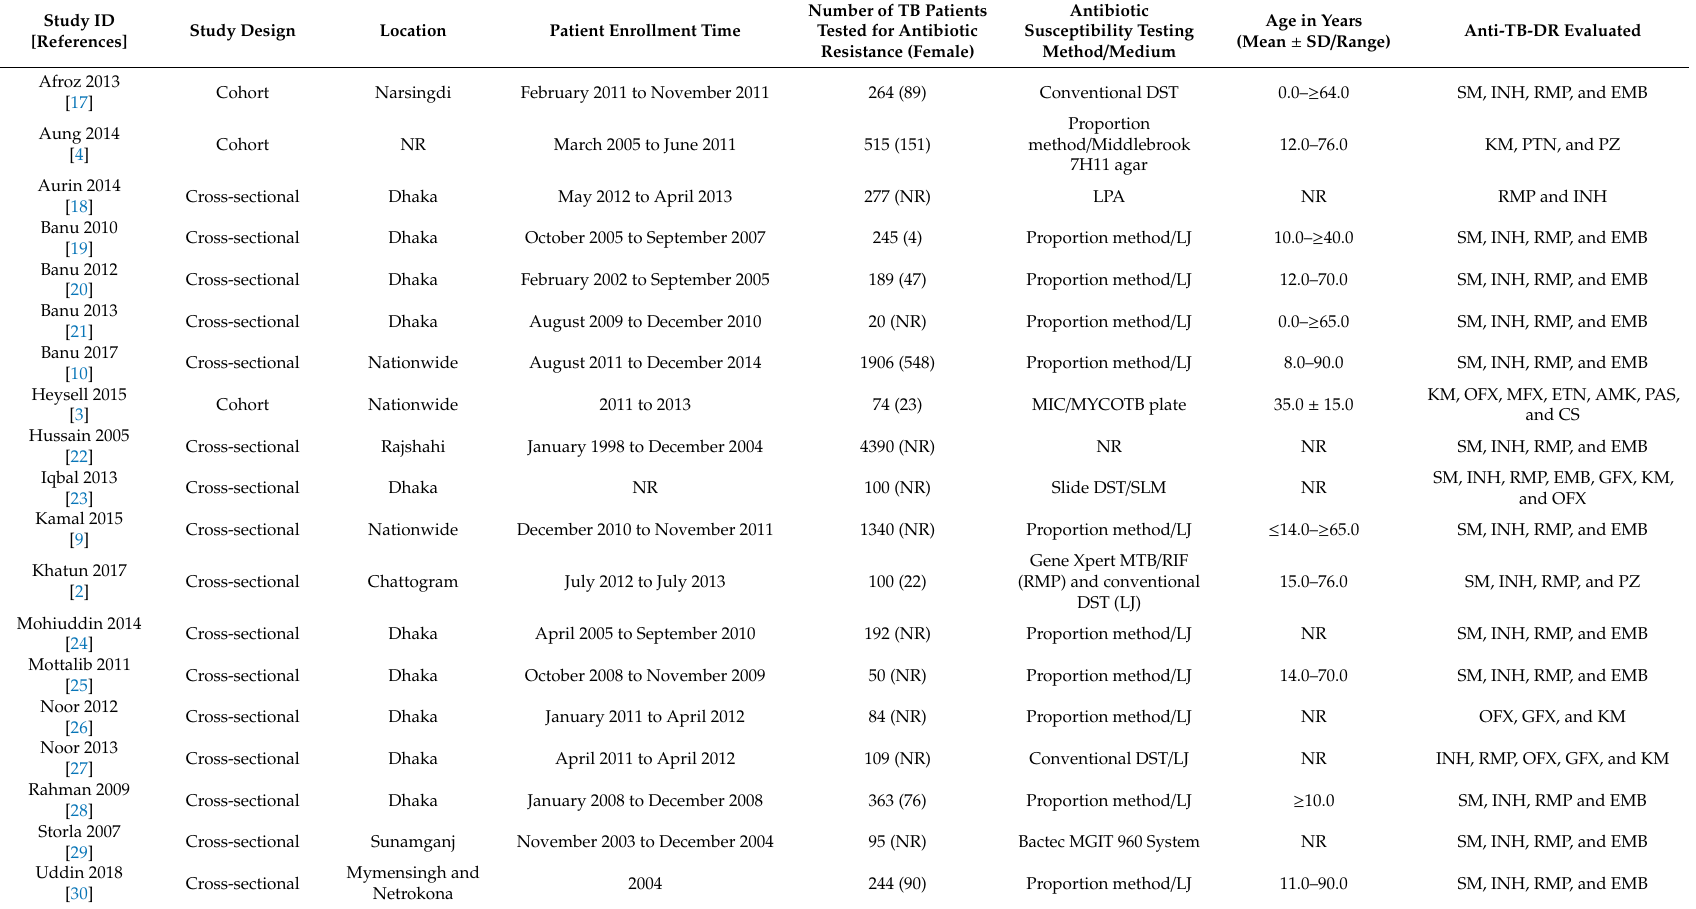
Table 1. Major characteristics of the included